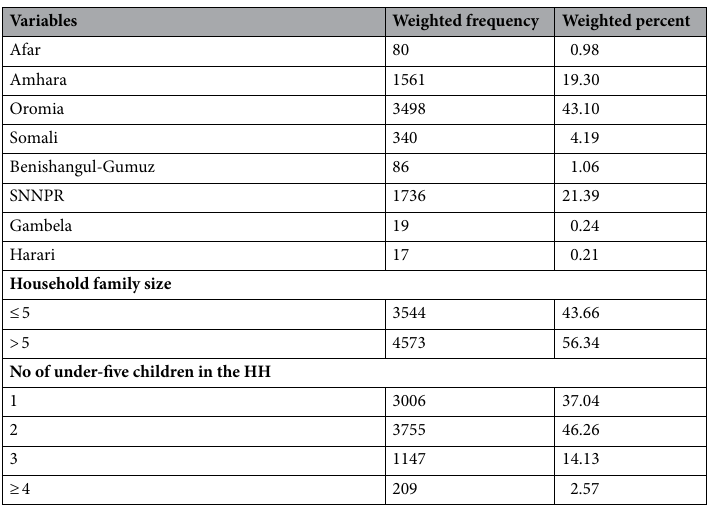
Table 1. Socio-demographic and other characteristics of children aged 6–59 months in Ethiopia from January 18, 2016 to June 27, 2016 (n =